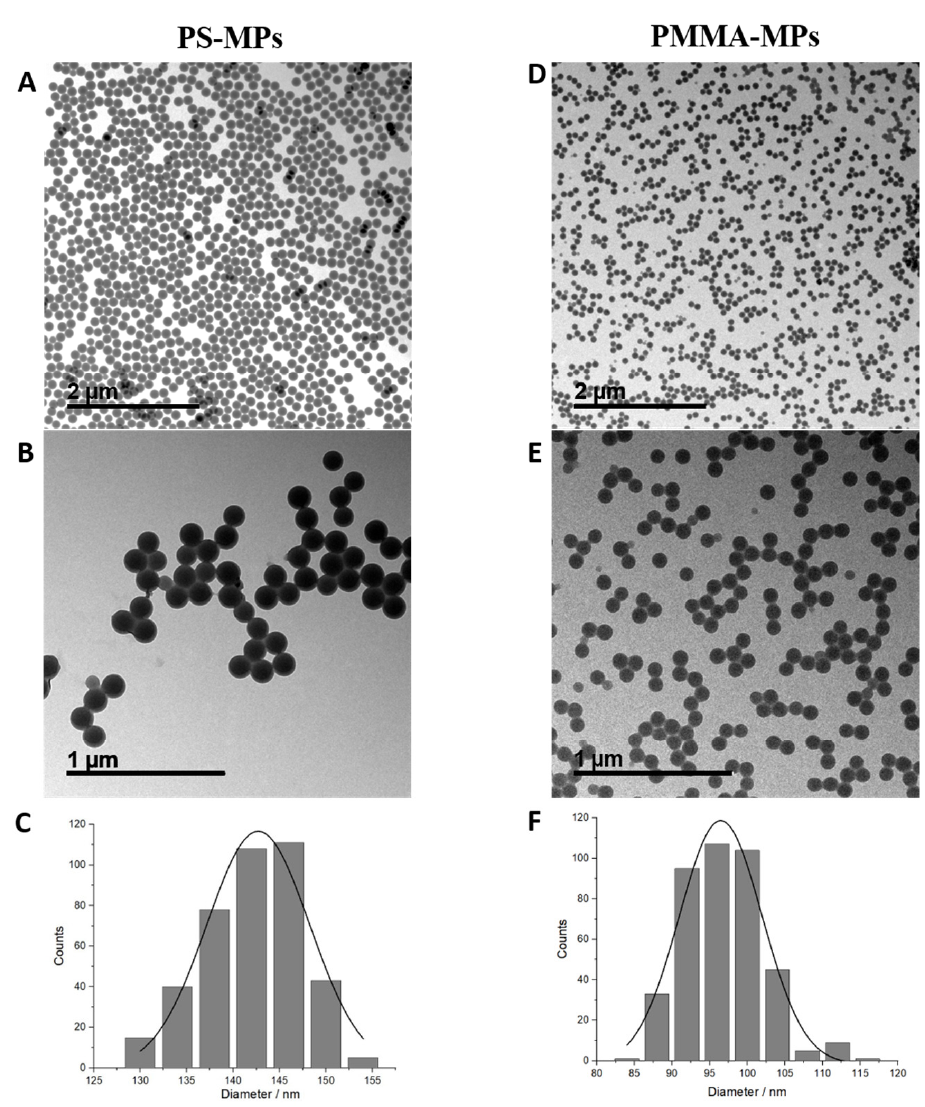
Figure 1. Stock solutions of polystyrene (PS) and polymethyl methacrylate (PMMA) microparticles in ultrapure water analyzed by transmission electron microscopy (TEM); bright field images ( A , B , D , E ); size distribution histograms ( C , F ). Three replicas ( n = 3) were investigated for each stock solution. Scale bar represents 2 μ m ( A , D ) or 1 μ m ( B , E ).